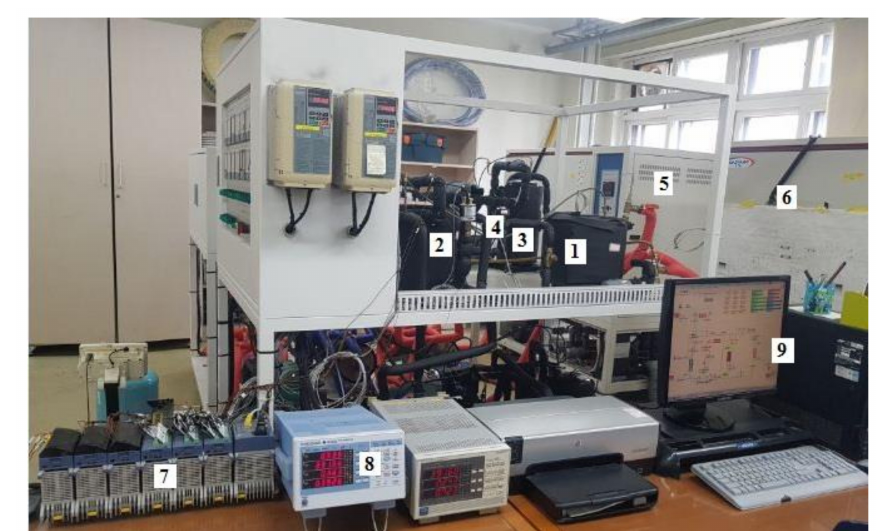
Figure 2. Picture of the experimental